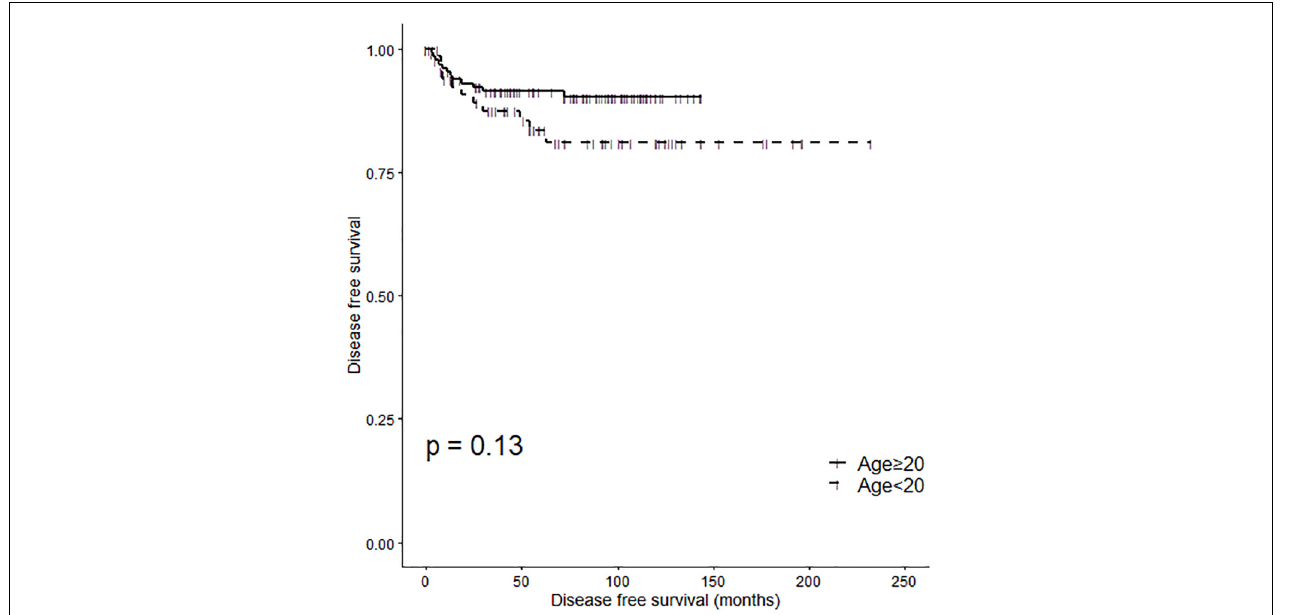
FIGURE 2 | Disease-free survival rates of subgroups according to age group (log rank p = 0.13).